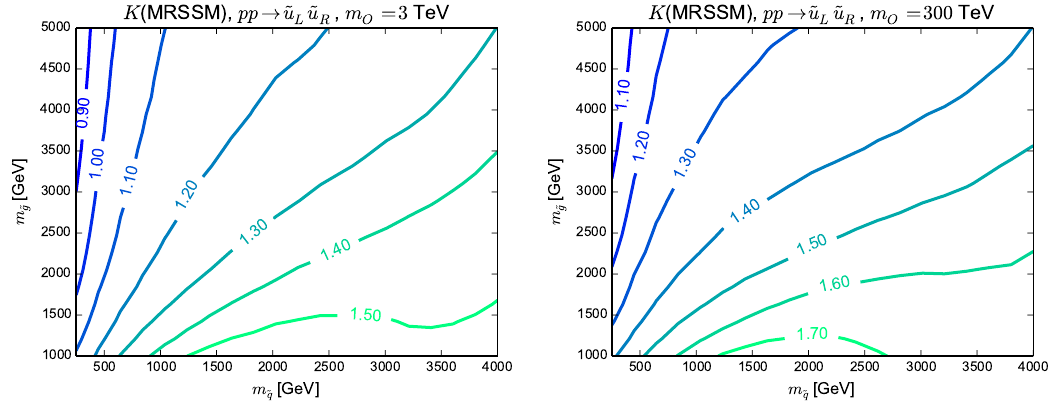
Figure 11. Shown are the MRSSM K-factors for ~ u L ~ u R production for two di(cid:11)erent octet masses.